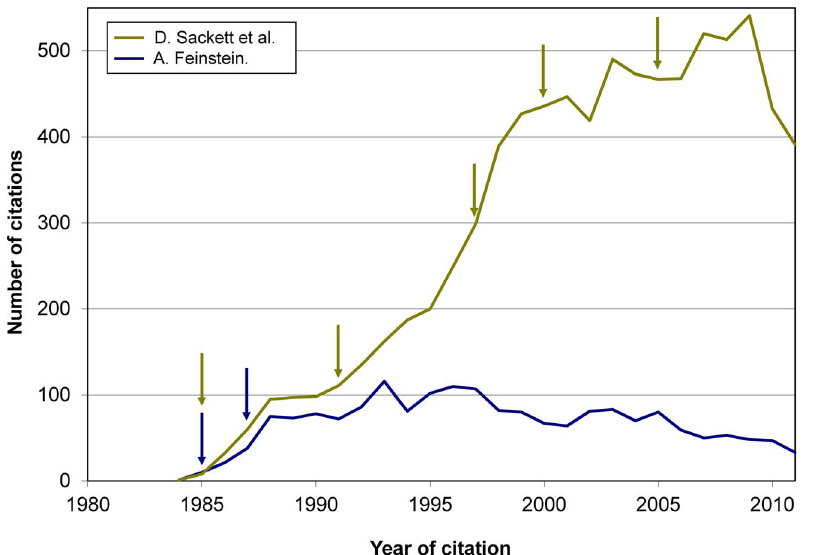
Figure 9. Citations to 2 books by D. Sackett et al. (8,150 citations) and 2 books by A. Feinstein (1,867 citations). [ Footnote: Arrows show the year of publication of all editions of each book. ]